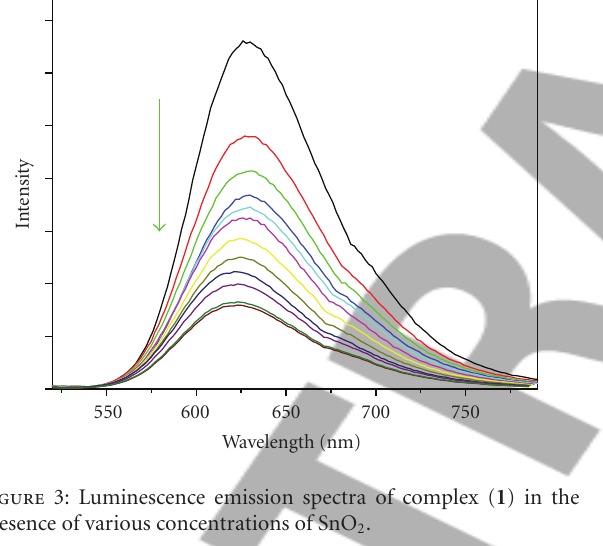
Figure 3: Luminescence emission spectra of complex ( 1 ) in the presence of various concentrations of SnO 2